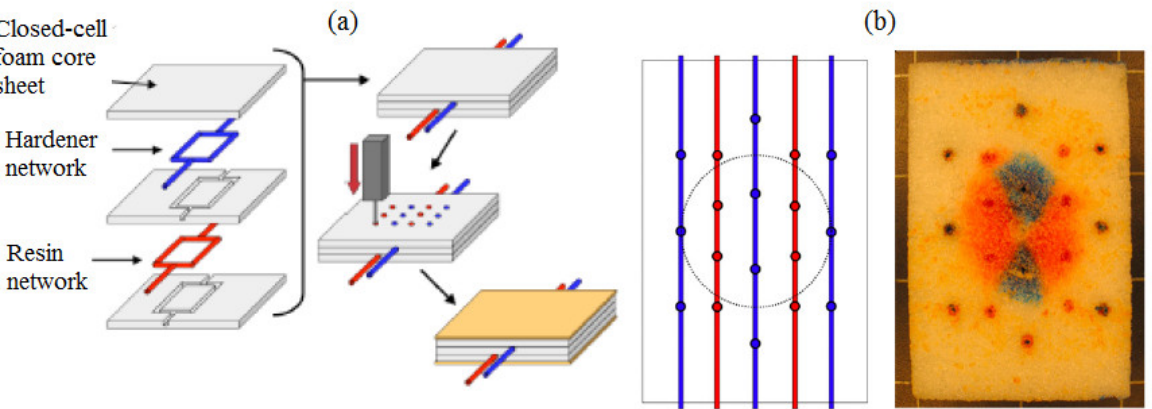
Figure 14. Illustration of self-healing after impact damage for the structure of fiber-reinforced polymers: ( a ) integration of the vasculature in composite sandwich panels and ( b ) damage healing (circle in the diagram) using a two-component adhesive delivered from an external reservoir. Reproduced from [148] with permission from IOP Publishing.